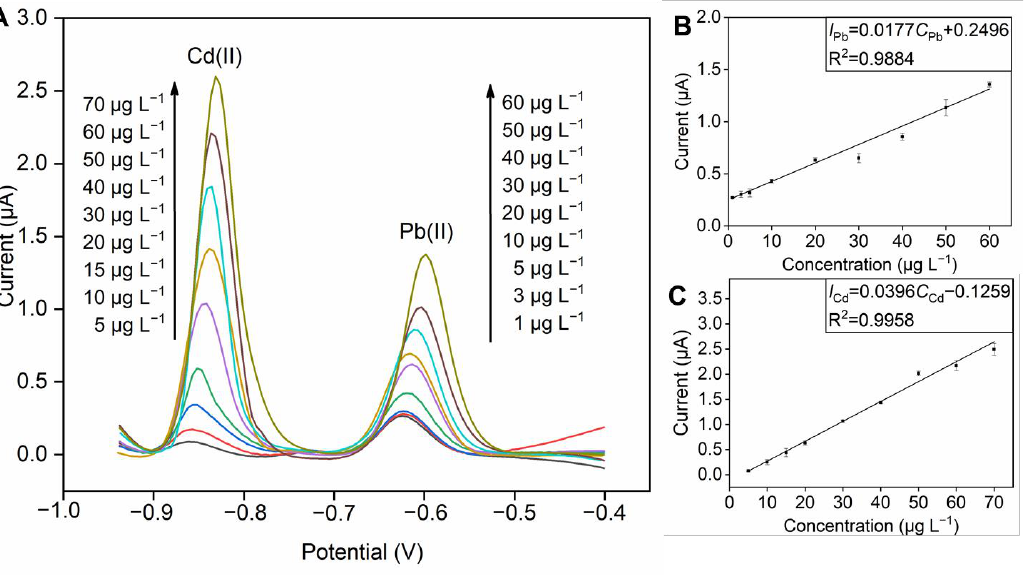
Figure 4. ( A ) Stripping voltammograms of the SPE/NPC for Pb(II) and Cd(II) with various concen- trations in acetic acid buffer solution with 0.81 mg L − 1 Bi(III) and the calibration plots of ( B ) Pb(II) trations in acetic acid buffer solution with 0.81 mg L ‒1 Bi(III) and the calibration plots of ( B ) Pb(II) and ( C ) and ( C ) Cd(II).